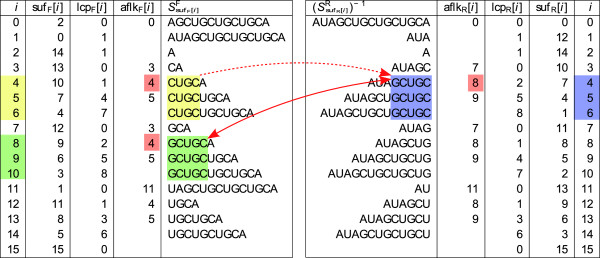
Affix array for S = AUAGCUGCUGCUGCA. Some lcp-intervals are marked by rectangles and the affix links from an lcp-interval to its reverse interval are represented by arcs. The solid arc points in two directions, from the the lcp-interval q = 5 - [8..10] in sufF (on the left-hand side) to its reverse interval q-1 = 5 - [4..6] in sufR (on the right-hand side) and vice versa. That is, q = (q-1)-1 (see Lemma 2). The dotted arc points in only one direction, from the lcp-interval q = 4 - [4..6] in sufF to its reverse interval q-1 = 5 - [4..6] in sufR. In this case, the reverse of q-1 is (q-1)-1 = 5 - [8..10], and q ≠ (q-1)-1.